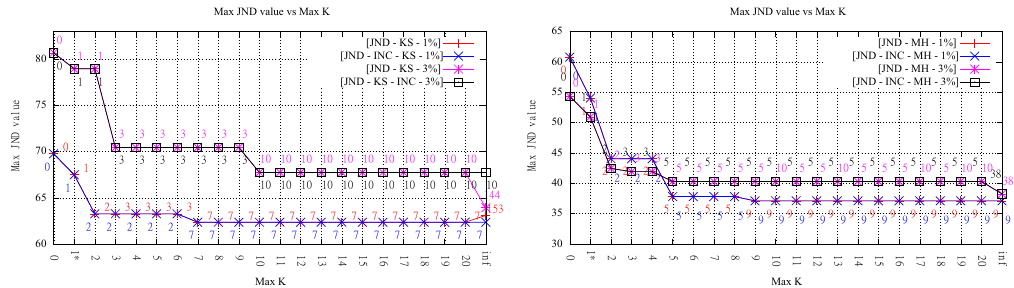
Figure 4. Minimization of maximum value for Kinzel Springs ( left ) and Moorehead SE ( right ) as the maximum order k increases. In each column, from top to bottom: ABN, WABN and JND. Numbers indicate the final order. * Maximum value for 1-exact-KLS, 1-exact-DT, LOP-0 k = 1 and LOP-INC k = 1 coincide. Therefore, and w.l.o.g., such value is referred as k = 1.